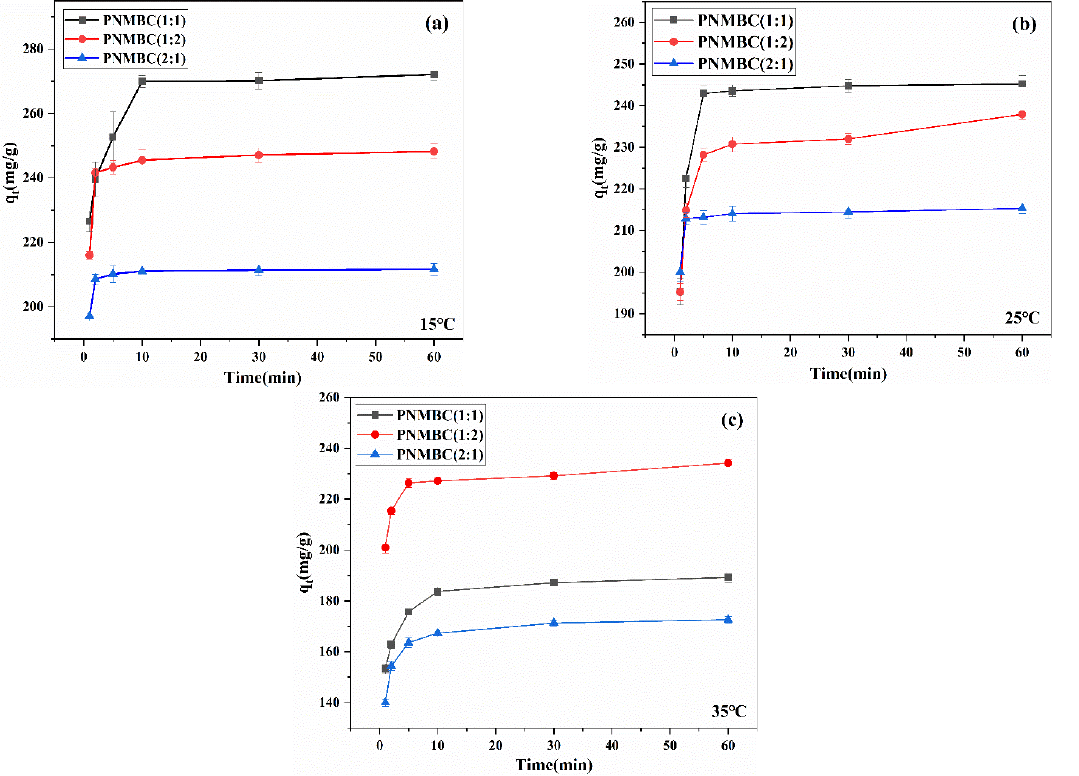
Figure 11. Effect of different ratios of PNMBC (1:1, 1:2, and 2:1) on the adsorption of Cu(II) at different contact times: ( a ) 15 °C, ( b ) 25 °C, and ( c ) 35 °C .